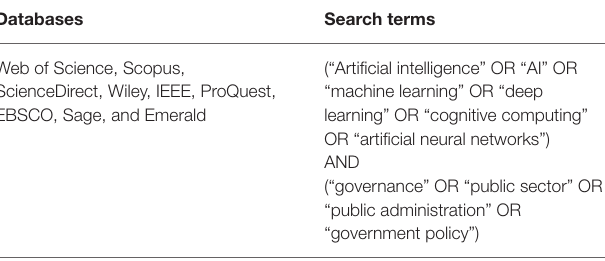
TABLE 1 | Databases and search terms